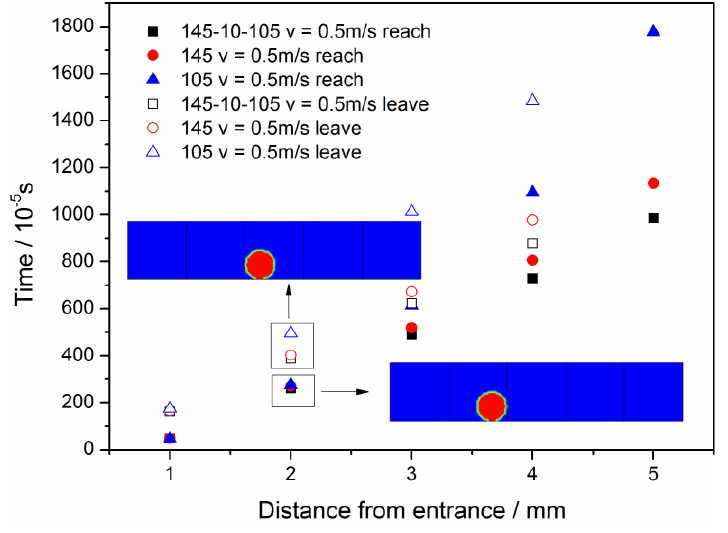
Figure 14. Comparison of time consumed between the modified flow channel and a conventional flow channel.